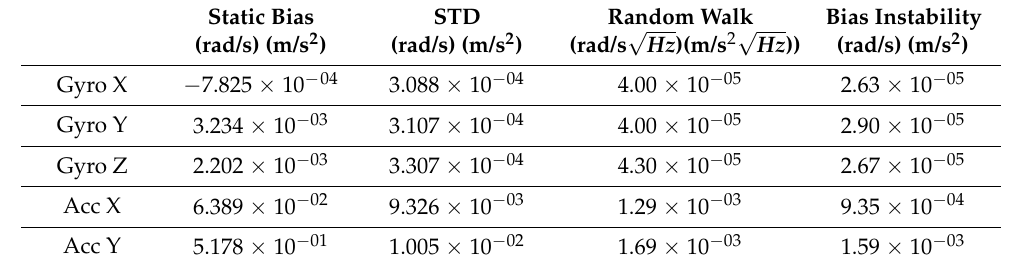
Table 1. Parameter estimation by Allan variance (AV).